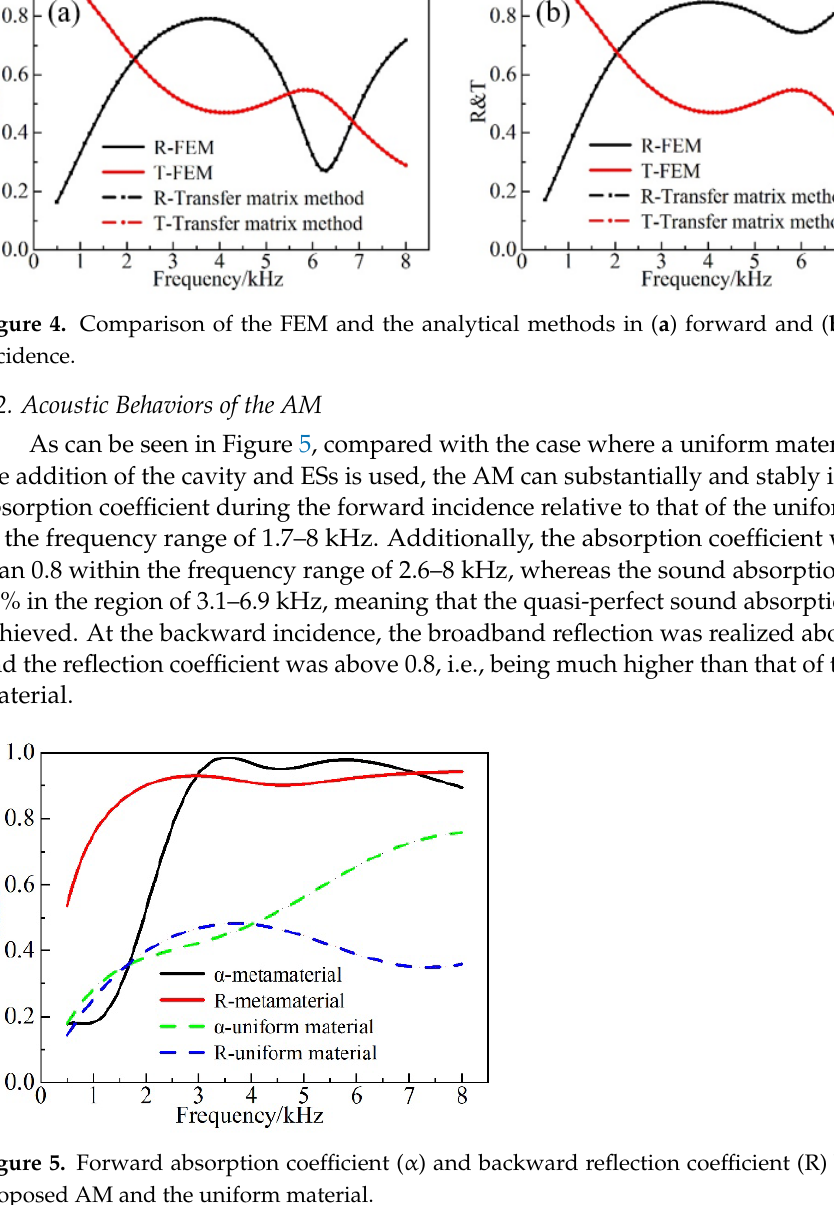
Figure 3. Finite element method (the verification model).